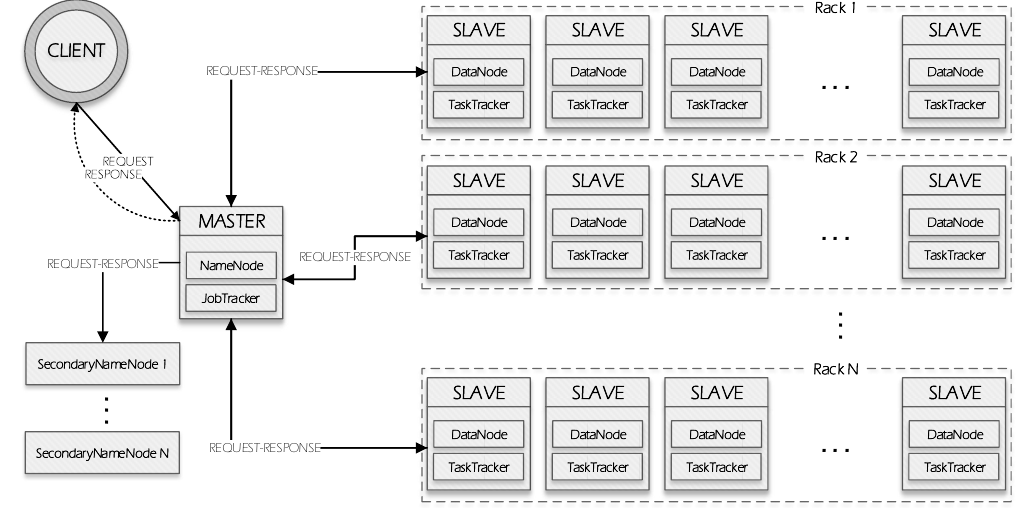
Figure 2. Hadoop Server Roles